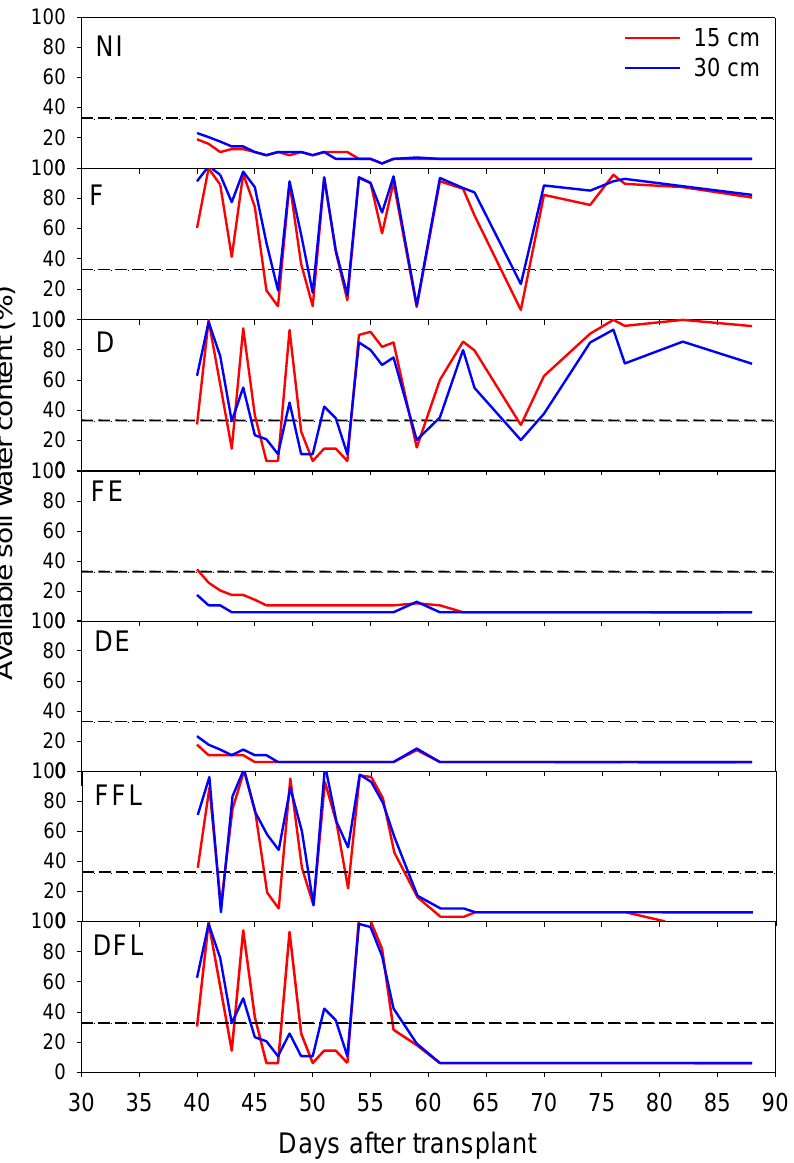
Figure 2. Available soil water contents at depths of 15 cm (red line) and 30 cm (blue line) in each irrigation treatment. Constant horizontal short-dash line indicates the minimum threshold of the available soil water content. NI: no irrigation, F: full, D: deficit, FE: full early, DE: deficit early, FFL: full flowering and DFL: deficit flowering.